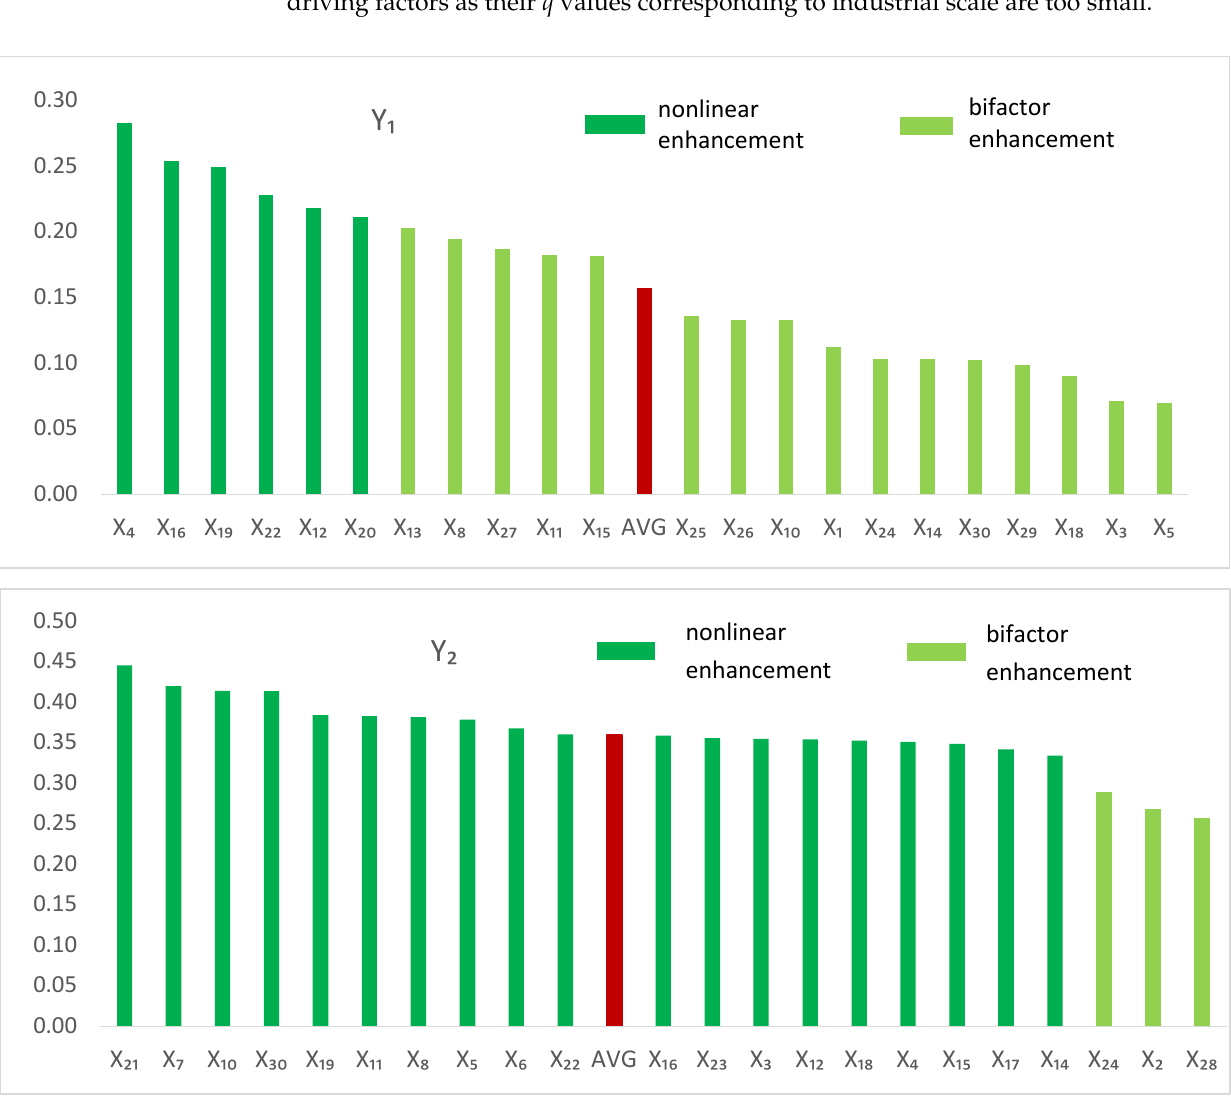
Figure 10. Average enhancement degree of factor interaction effect. Note: Red represents the average